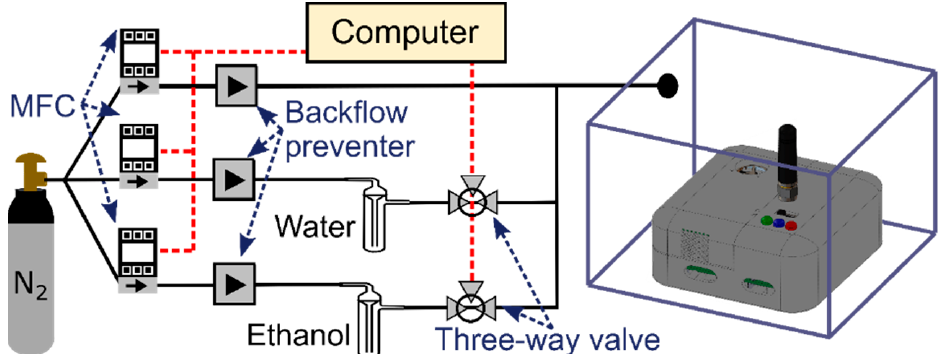
Figure 3. Schematic of the automated experimental setup used to characterize the sensor responsivity to different chemicals species (ethanol and water vapour) diluted in a N 2 carrier gas. The sensing platform is located inside a plexiglass enclosure.